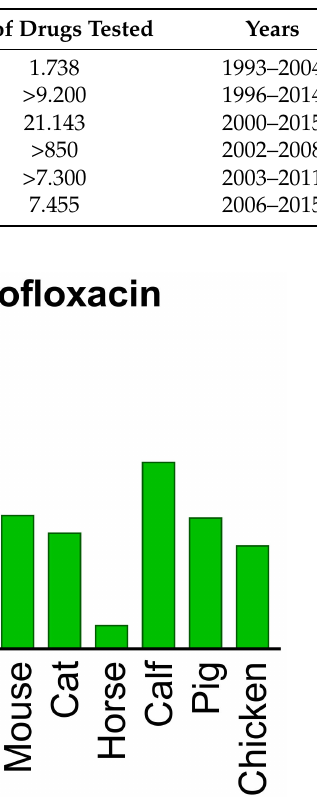
Table 1. Failure rates of substances entering Phase I trials.